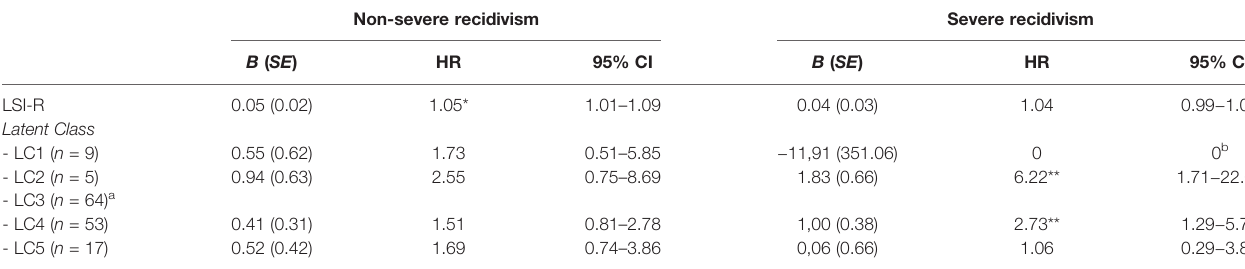
TABLE 6 | Cox proportional hazard regression analyses predicting non-severe and severe recidivism by Latent Class.